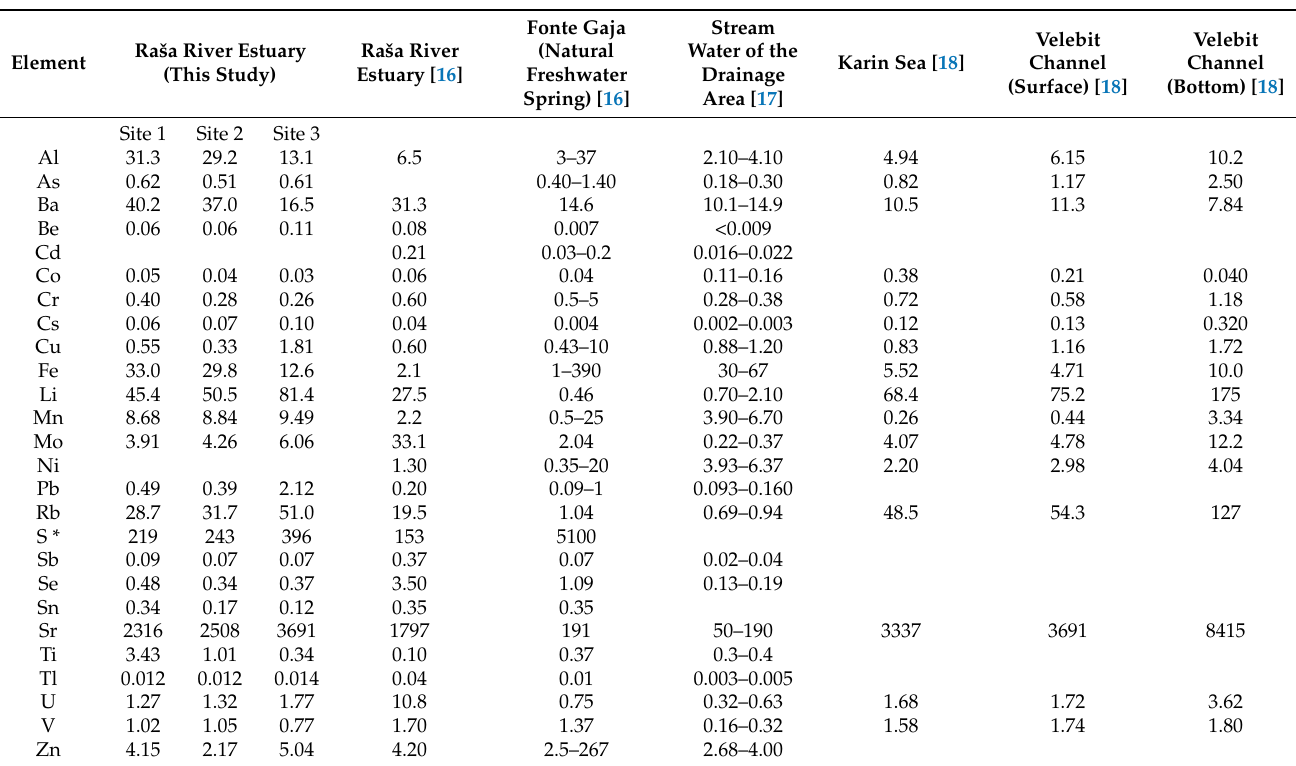
Table 2. Comparison of mean element concentrations in the surface layer of the Raša River estuary with literature values, expressed in µ g L − 1 or * mg L − 1 .